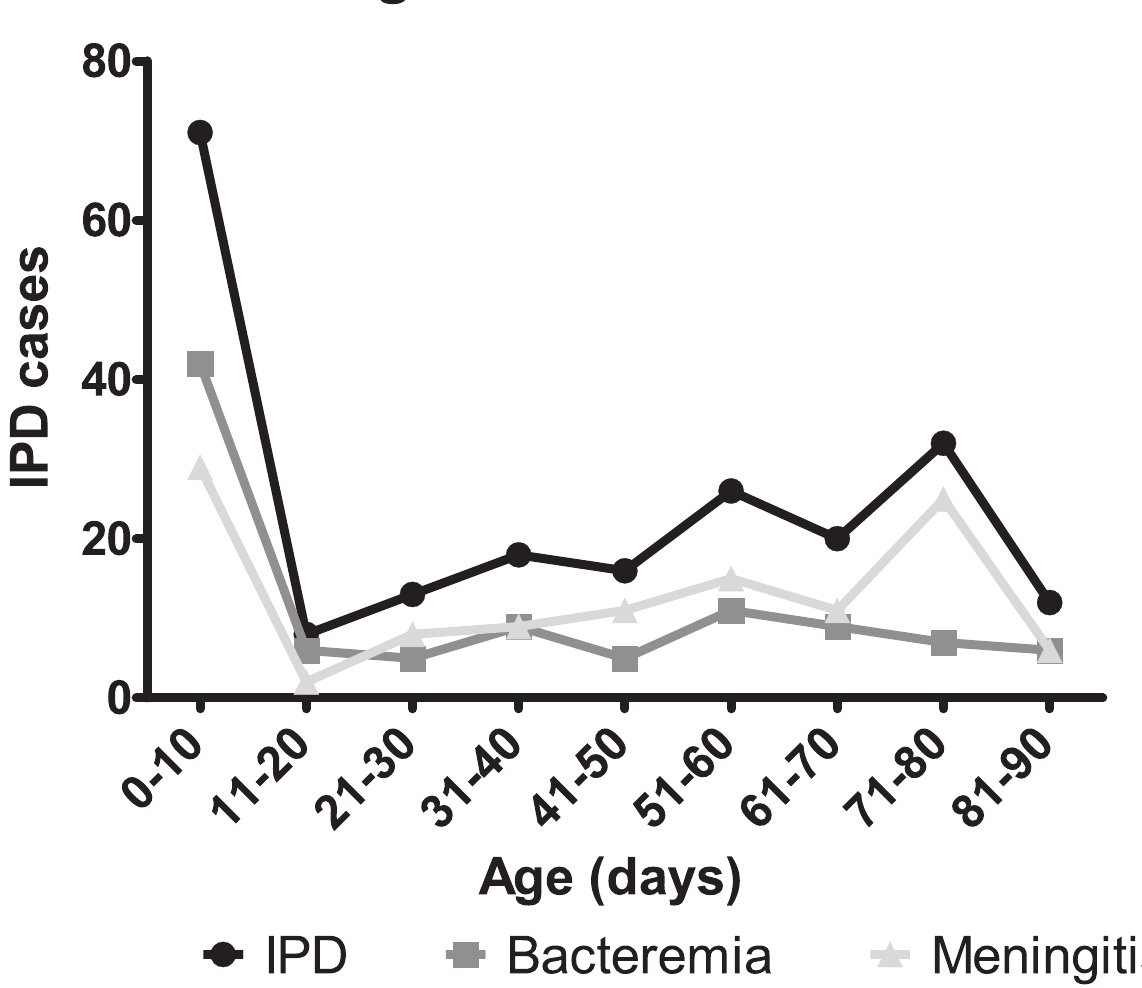
Figure 3. Number of cases of IPD (in total, meningitis, and bacteraemia) in children younger than 90 days from 1943 through 2013.